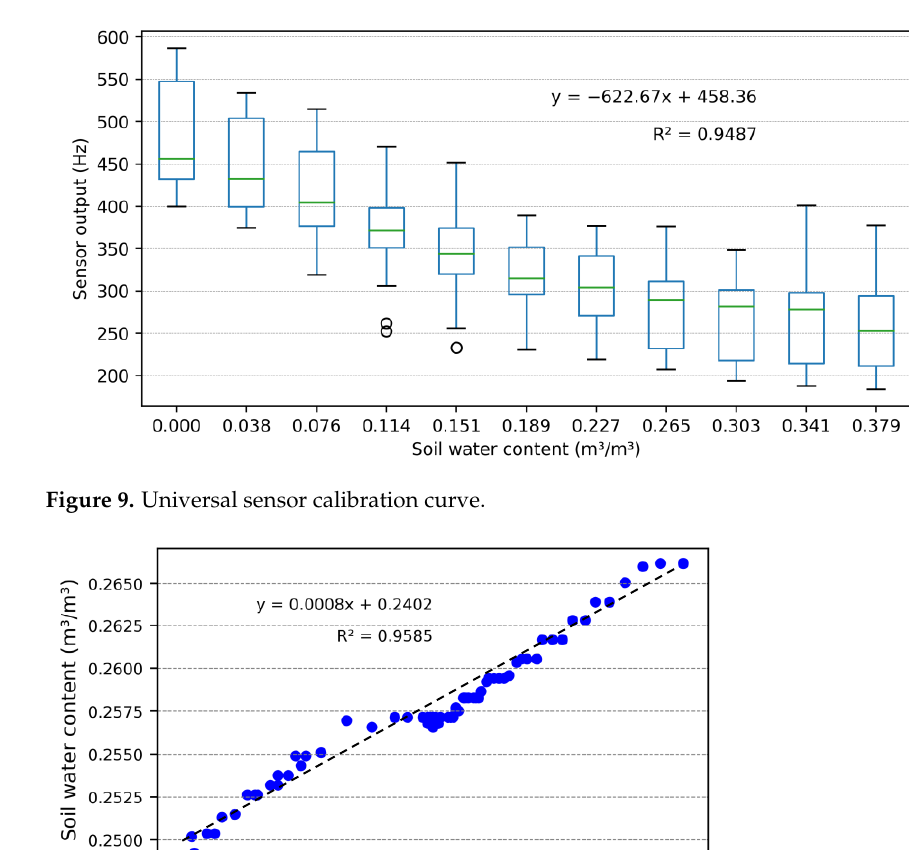
Figure 8. Single-point calibration curves for ( a ) group 1 and ( b ) group 2.